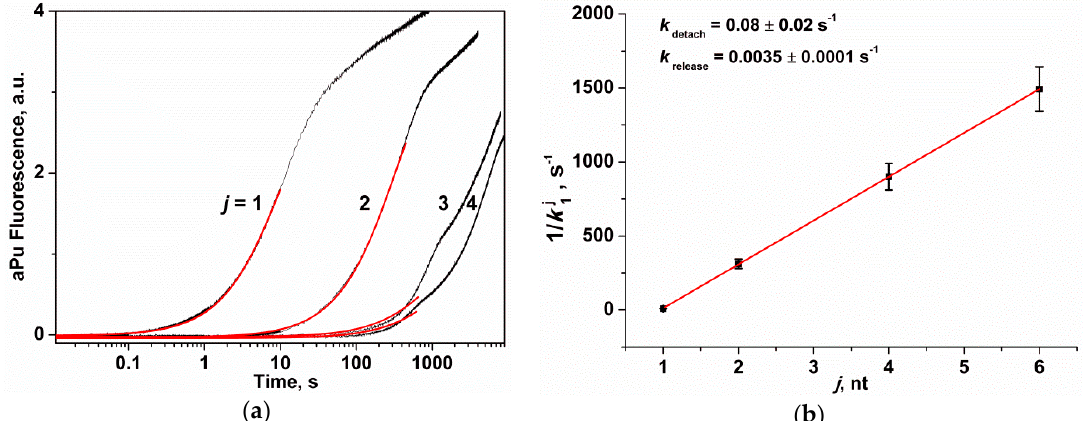
Figure 6. The change in the fluorescence intensity of aPu in the course of APE1 interaction with substrates Exo-aPu j /T . ( a ) Exponential analysis (red line) of the initial part of the kinetic curves ( j is the position of the nucleotide relative to the 3 ′ end of the short oligonucleotide). [ Exo-aPu j /T ] = 1.0 μ M, [APE1] = 2.0 μ M. ( b ) Dependence of k 1 j on j , which is described by Equation (2).